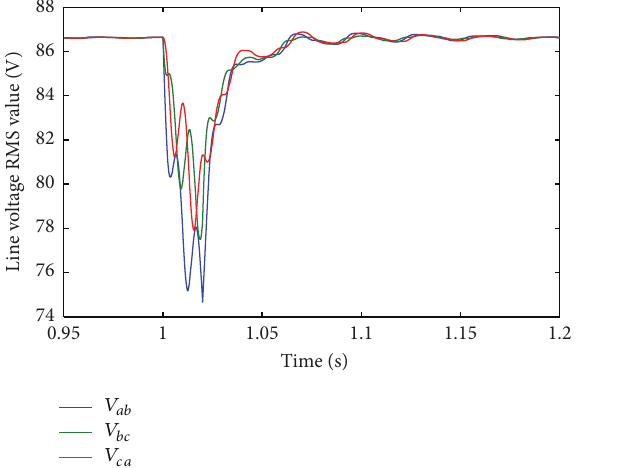
Figure 13: RMS of line-voltage response to load disturbance.